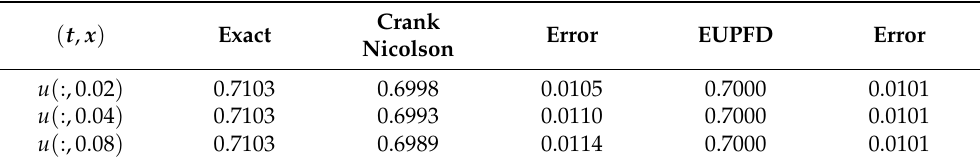
Table 8. Infinity norm results of the nonlinear ADR equation by using the exact, Crank–Nicolson, and EUPFD solutions.